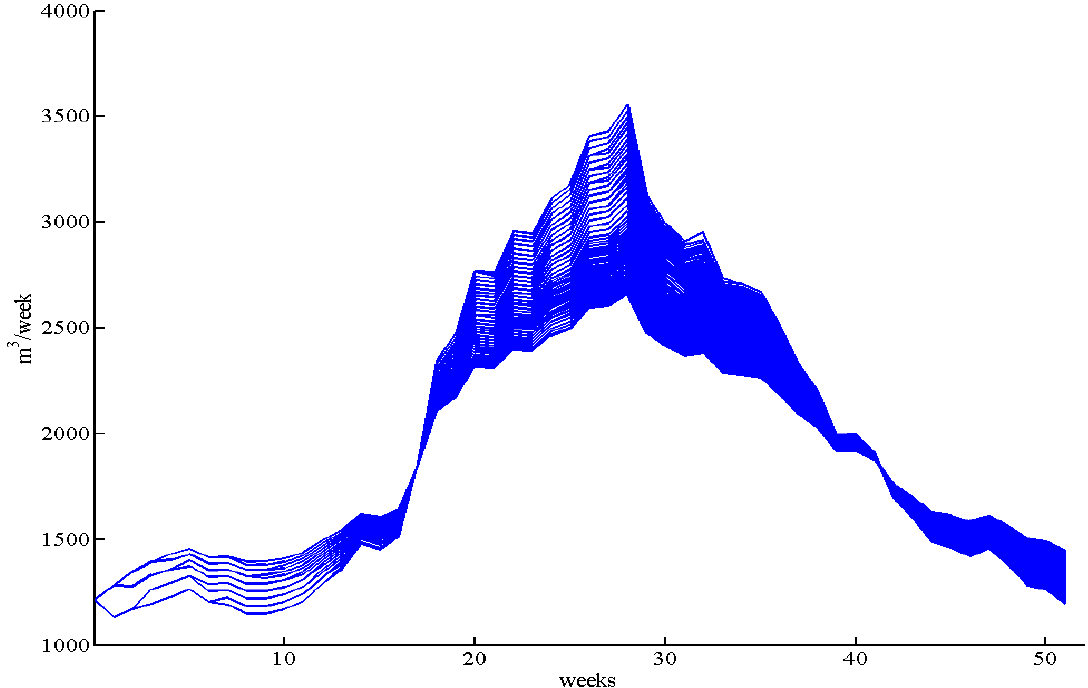
Fig. 4. Scenario tree of annual stochastic inflows to reservoir 6.